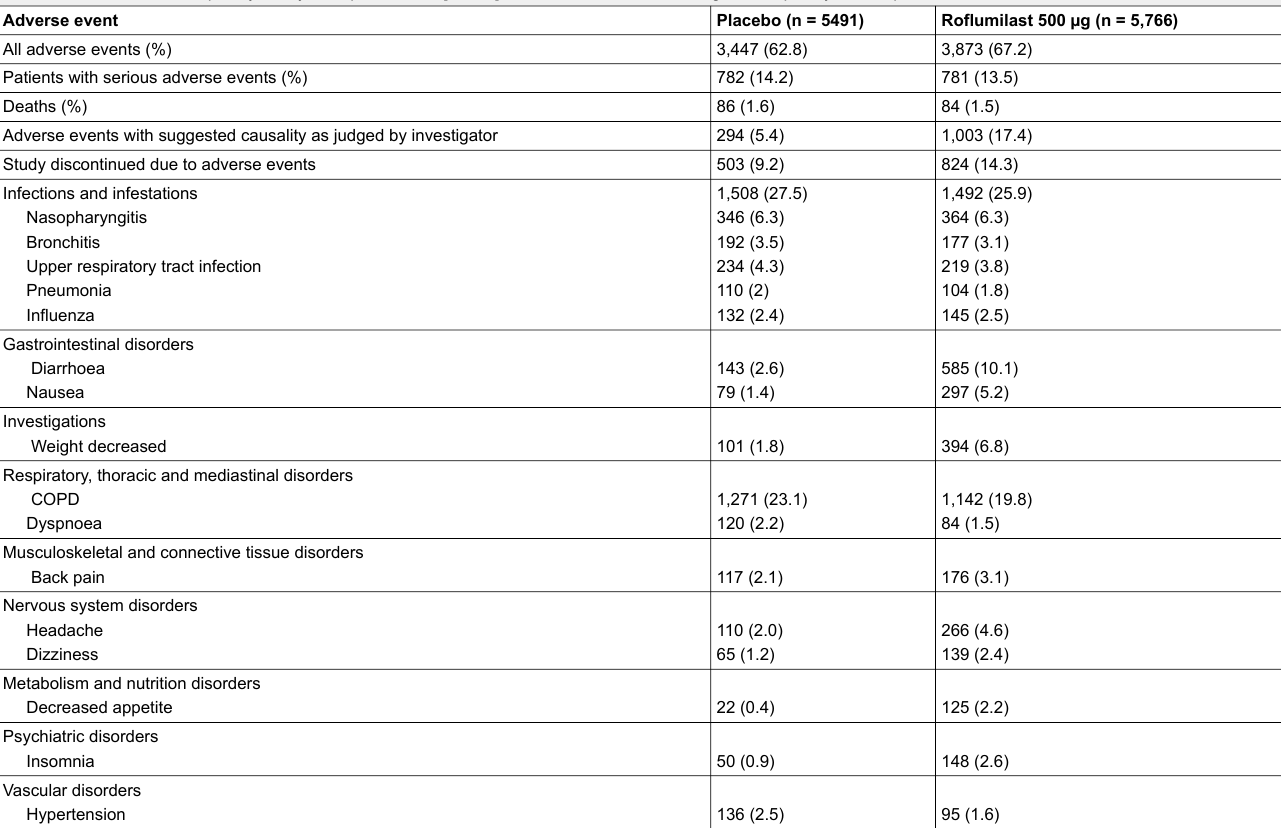
Table 4: Adverse event frequency: analysis of pooled data [15, 28]. All adverse events occurring at a frequency ≥2% in patients treated with roflumilast are listed. Adverse event All adverse events